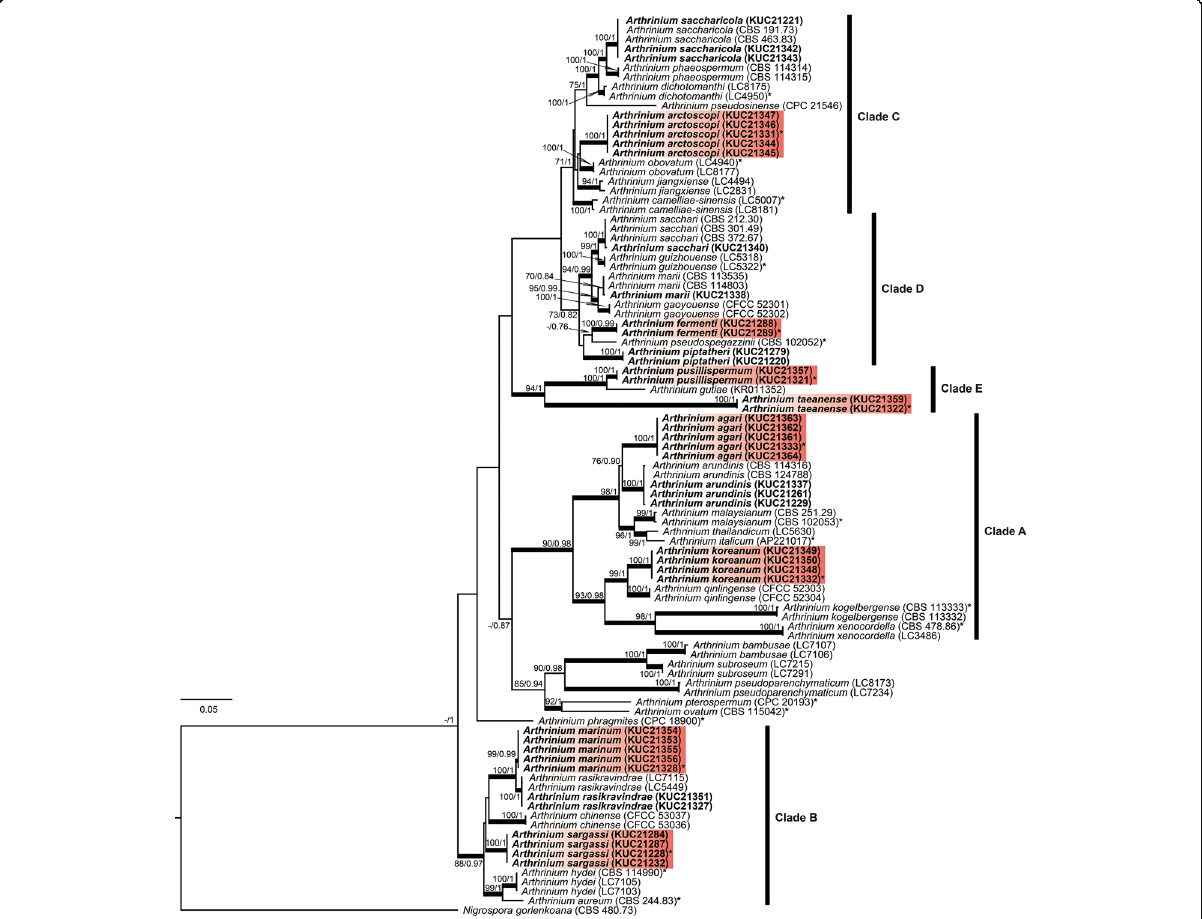
Fig. 2 ML tree based on the ITS, TUB, and TEF regions combined. The numbers at the nodes indicate ML bootstrap support (BS) > 75% and Bayesian posterior probabilities (PP) > 0.75 as BS/PP. The thickened branches indicate support greater than 85% for BS and 0.95 for PP. A hyphen ( ‘ - ‘ ) indicates values of BS < 70% or PP < 0.75. Ex-holotype strains are indicated with asterisks ( ‘ * ’ ). The fungal cultures examined in this study are shown in bold. Red boxes indicate the novel species. The numbers in the brackets indicate strain number. The scale bar indicates the nucleotide substitutions per